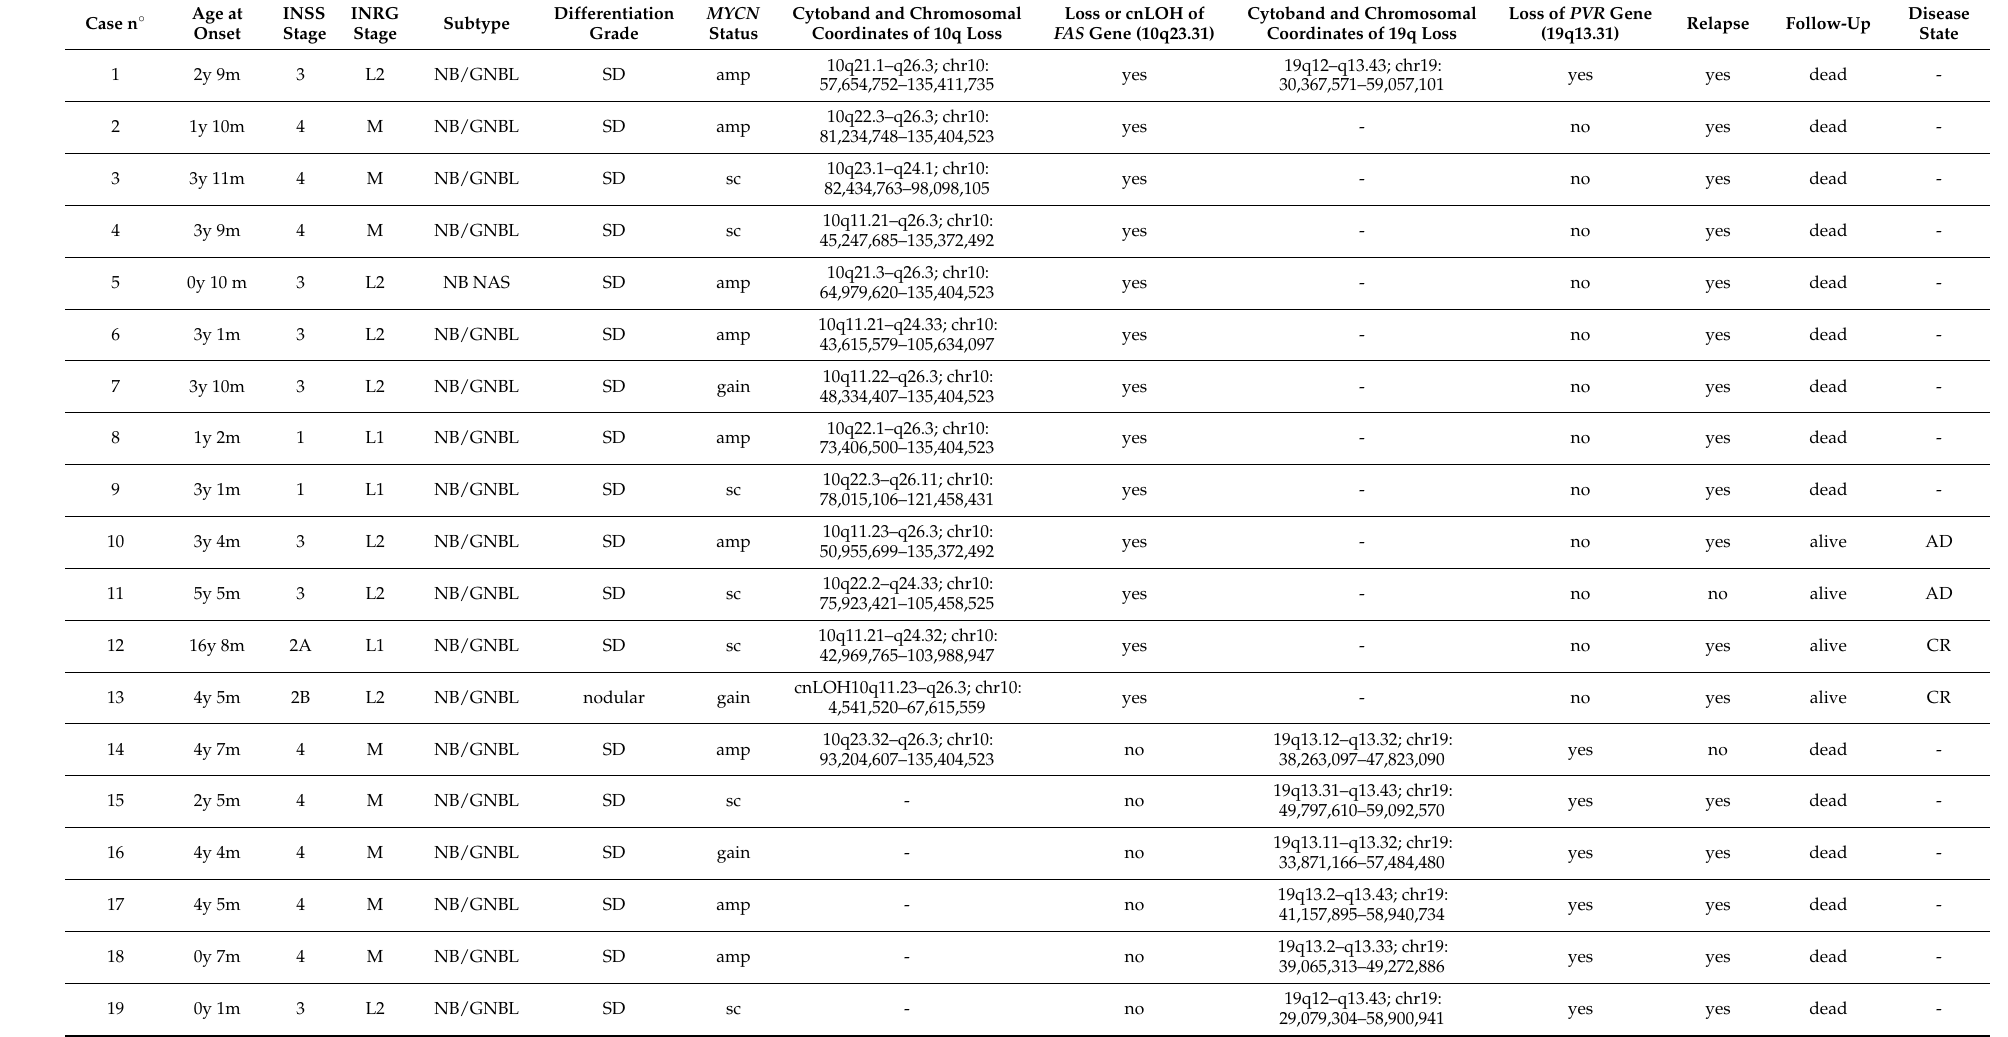
Table 2. Diagnostic characteristics of NB patients with tumors showing loss of 10q and/or loss of